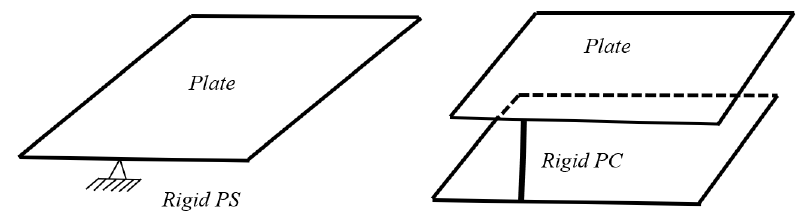
Figure 6. Parent structure subjected to rigid point